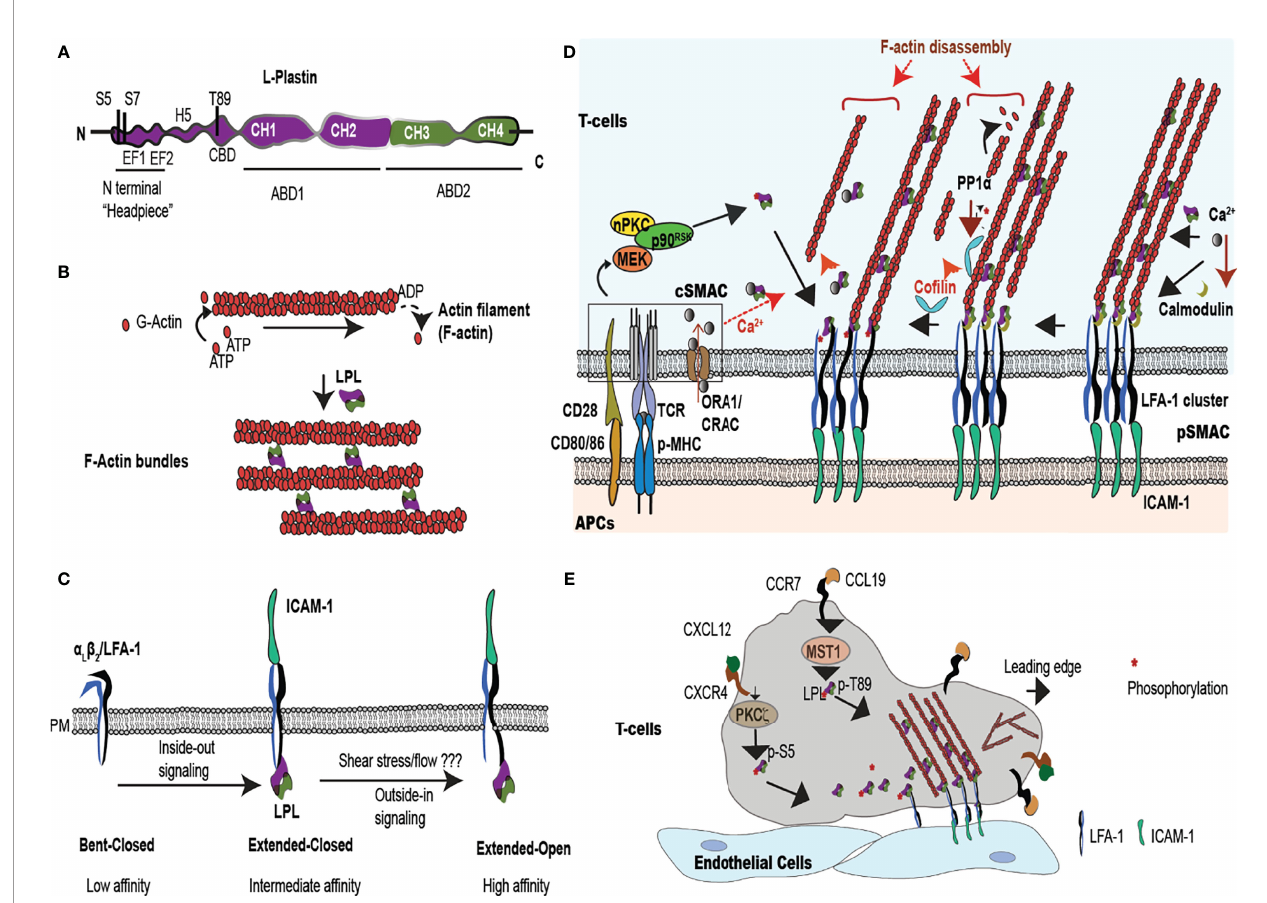
FIGURE 1 | LPL is an actin-bundling protein that supports T cell synapse maturation and migration. (A) LPL comprises a regulatory ‘ N-terminal headpiece ’ and two actin binding domains (ABDs). The regulatory headpiece includes three known phosphorylation sites (Ser-5, Ser-7, Thr89), two calcium binding EF domains, a regulatory H5 “ switch helix, ” and a calmodulin binding domain (CBD). (B) LPL cross-links two actin fi laments to generates f-actin bundles. (C) LPL interacts with the cytoplasmic tail of the b 2 subunit of the integrin LFA-1. In T cells, inside-out signaling induces a conformational change from low to intermediate af fi nity, whereas shear fl ow or ICAM-1 engagement triggers the high-af fi nity, extended-open conformation. (D) Multiple regulatory pathways converge upon LPL in the pSMAC, where LFA-1 mediates tight approximation to ICAM-expressing APCs. The IS, the interface at the site of T-cell:APC contact site, generates a cSMAC, pSMAC and a dSMAC (dSMAC not shown). In the IS, TCR ligation to peptide-loaded MHC (pMHC) and costimulatory CD28:CD80/86 interactions occur in the central super-molecular activation complex (cSMAC), which activates a kinase cascade [nPKC-MEK- ribosomal protein S6 kinase p90 (p90 RSK )]. This kinase cascade results in Ser-5 phosphorylation of LPL. LPL phosphorylation accelerates LFA-1 clustering in the peripheral SMAC (pSMAC). Phosphorylated LPL is largely associated with high af fi nity LFA-1, and may stabilize the IS. LPL can also bind to LFA-1 independently of phosphorylation. LPL- induced LFA-1 clusters further accumulate at IS by co fi lin-mediated f-actin remodeling. Co fi lin is activated by PP1 a phosphatase. Simultaneously, LPL also recruits f-actin bundles to connect the IS to actin cytoskeleton. Ca 2+ in fl ux at cSMAC also regulates LPL. Ca 2+ binding reduces the LPL bundling ef fi ciency, perhaps allowing f-actin clearing at IS. However, lower Ca 2+ in the pSMAC permits calmodulin binding to LPL, stabilizing actin bundles and maintainting LFA-1 clustering. (E) Intravascular T cells traf fi c to peripheral immunological sites via the binding of the integrin LFA-1 to the adhesion molecule, ICAM-1, expressed on vascular endothelial cells. In response to chemoattractants, such as CXCL12 and CCL19, T cells polarize the respective chemokine receptors CXCR4 and CCR7 to the leading edge and activate kinases such Mst1 and PKC z . Mst1, PKC z , and other kinases phosphorylate the regulatory headpiece of LPL. Phosphorylated LPL initiates LFA-1 clustering, sustaining ICAM-1 binding. Branched f-actin forms in the lamellipod, while the ‘ uropod ’ propels cells in a forward direction. The symbol "*" indicates the phosphate group during phosphorylation/dephosphorylation